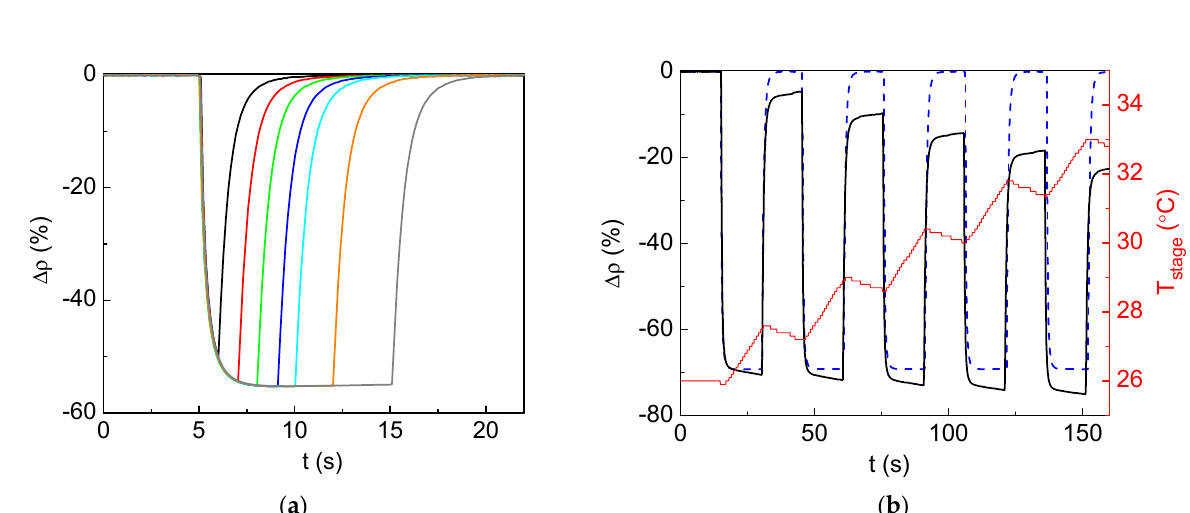
Figure 3. Percentage change of the resistivity for NNO films on ( a ) LSAT and ( b ) SiO 2 substrates at fixed temperature T = 26 °C and periodical 15-s illumination by the blue laser at different optical power: 0.2, 0.4, 0.8 and 1.2 W.